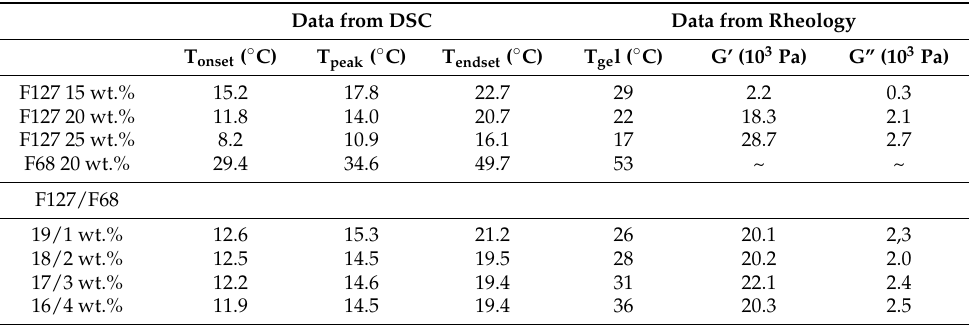
Figure 2. Micellization behavior of single ( A ) and binary ( B ) Pluronic solutions as a function of temperature obtained from differential Scanning Calorimetry (DSC) measurements. Table 1. T onset , T peak , and T endset of F127 and F127/F68 micellization peaks obtained from DSC measurements. Gelification temperature (T gel ) and elastic G’ and viscous moduli G” of F127 and F127/F68 hydrogel at 50 °C.